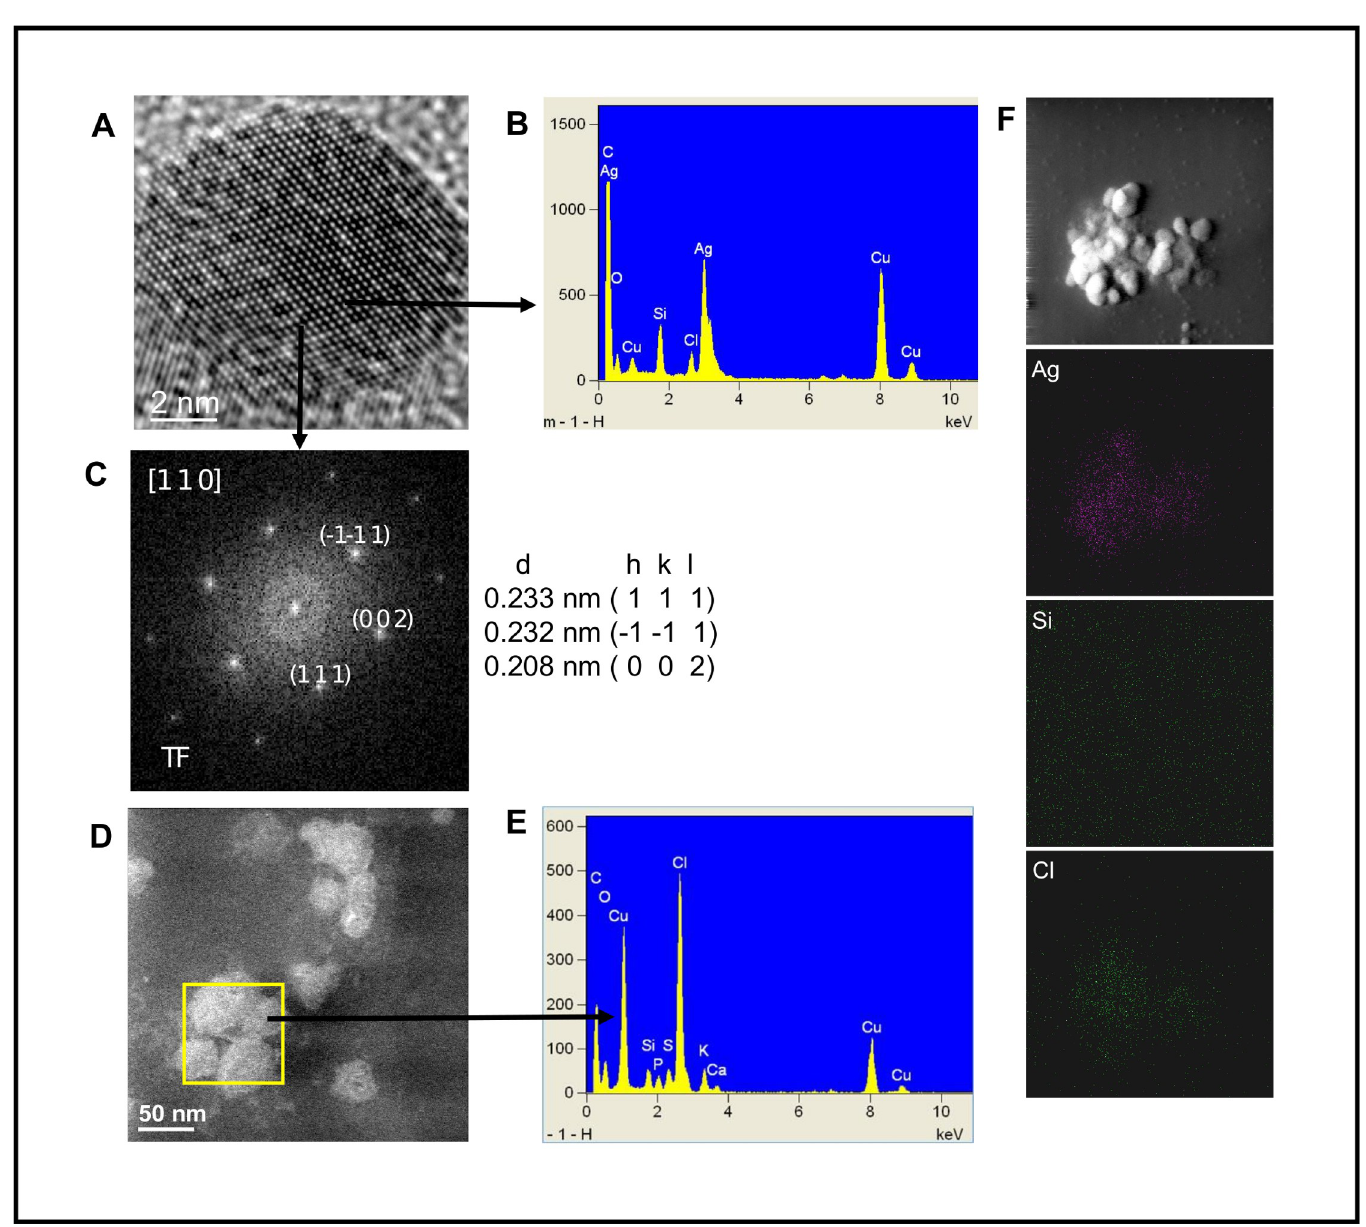
Fig 6. Crystalline structure and elemental composition of AgNPs biosynthesized with free-cell water-filtrate of the Fusarium scirpi Ag0.5–5 strain. (A) HRTEM image that shows an AgNP. (B) Energy dispersive X-ray (EDX) spectrum obtained in the AgNP. (C) FFT pattern of the atomic resolution image. (D) ADF-STEM image that shows the amorphous material in the negative control sample and the area selected for EDX analysis. (E) EDX spectrum of the negative control selected area. (F) Elemental chemical mapping of an AgNP